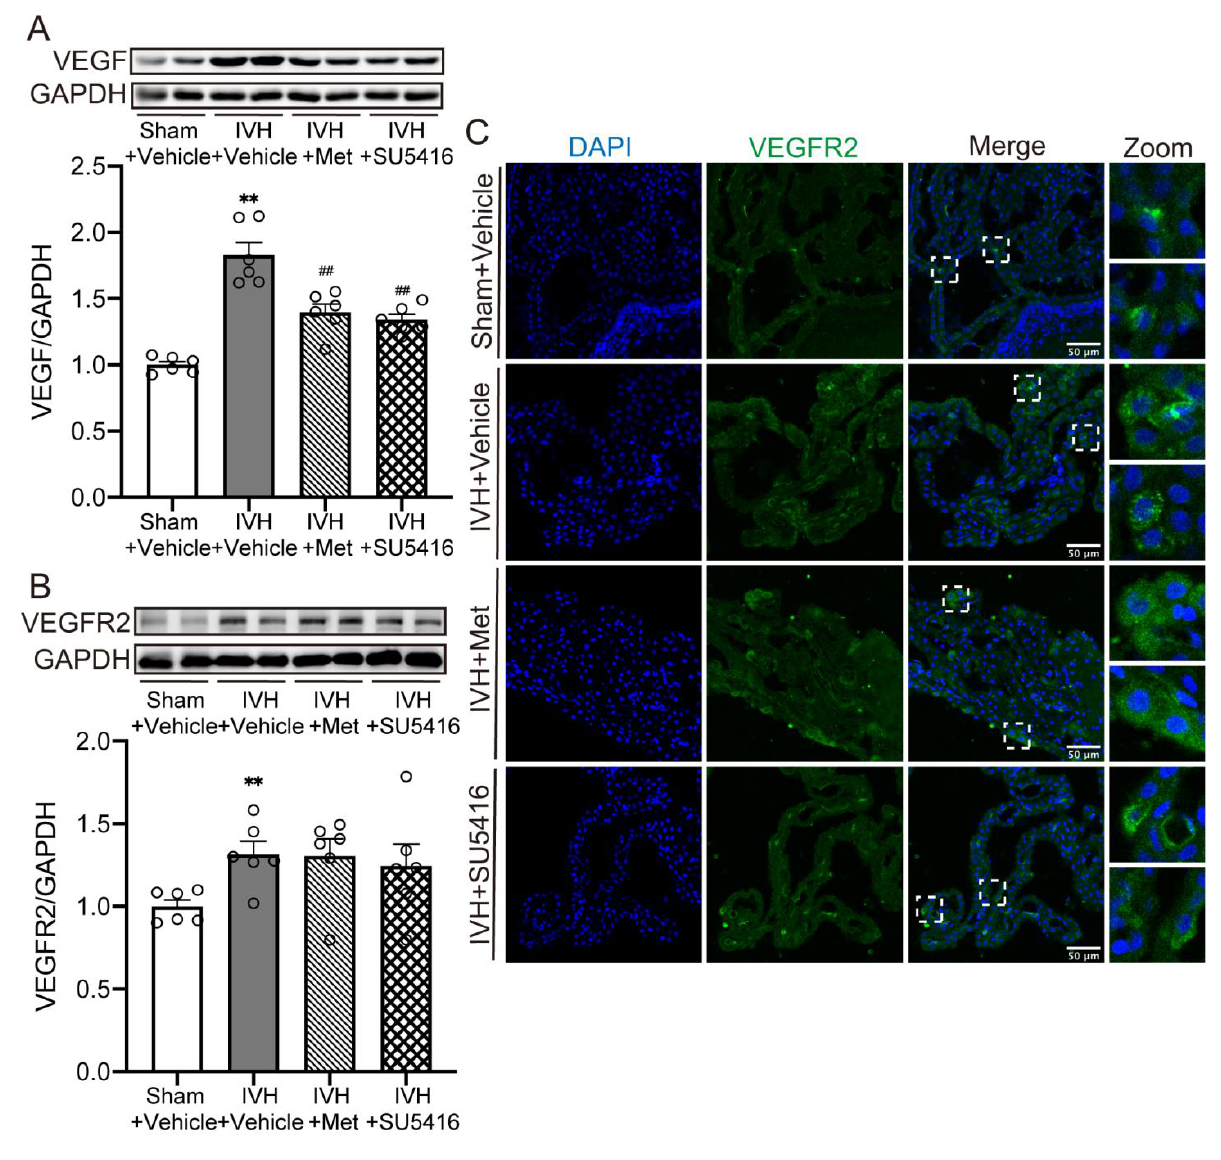
Figure 4. Metformin decreased the upregulated expression of VEGF after IVH ( A ) Western blot showed the VEGF expression level in choroid plexus, n = 6. ( B ) Western blot showed the VEGFR2 expression level in choroid plexus, n = 6. ( C ) immunofluorescence staining of coronal sections showed the expression of VEGFR2 in choroid plexus, n = 4, Scale bar = 50 μ m. Data were analyzed by one-way ANOVA with a Tukey ’ s post hoc test. Values are means ± SEM, ** p < 0.01 vs. sham, ## p < 0.01 vs. IVH + Vehicle.